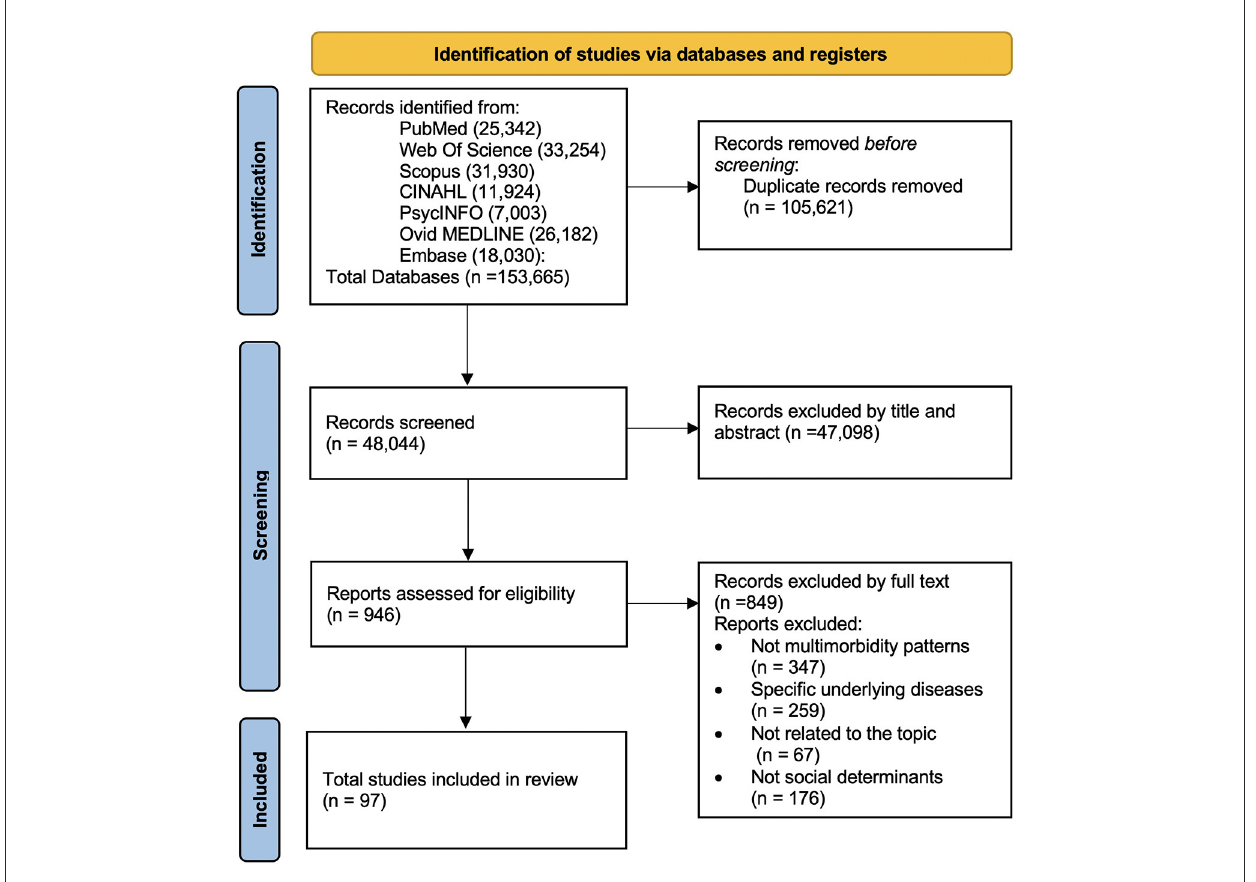
FIGURE1 PRISMA flow diagram